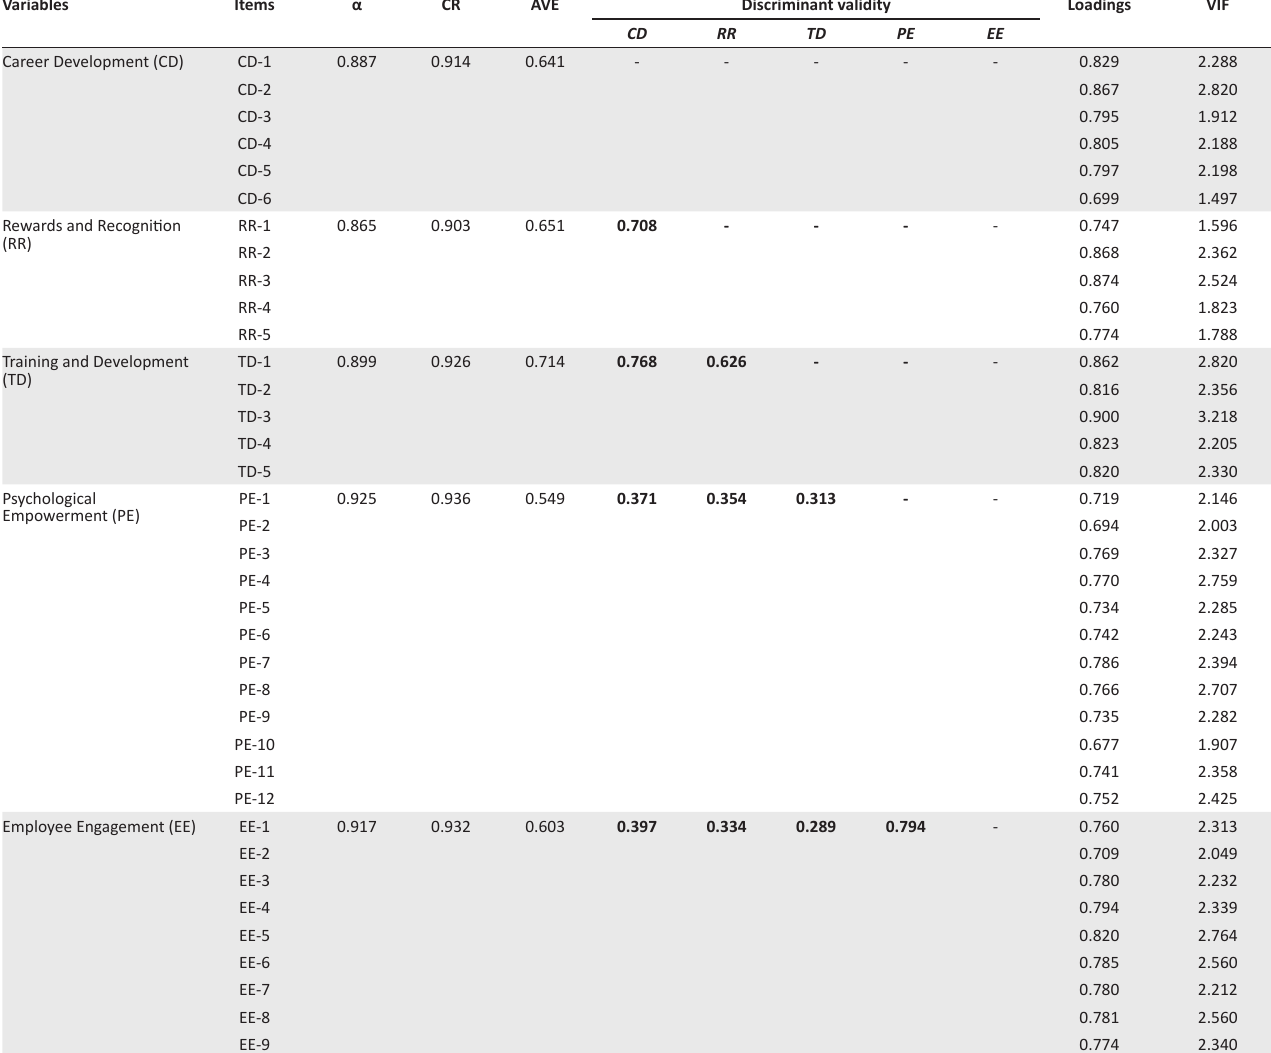
TABLE 1: Reliability, discriminant validity, factor loadings and collinearity statistics. Variables Career Development (CD)